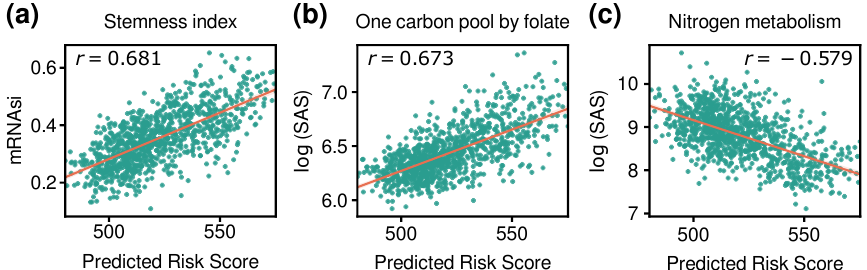
Figure 7. Scatter plots represent the relationship between the risk score and other indices. ( a ) The stemness index is a value to measure oncogenic dedifferentiation. The risk score showed a strong positive correlation with the mRNA stemness index ( p = 9.62 × 10 − 140 ). ( b ) SAS is a score to measure the degree of activity of a subsystem (e.g., pathway). The risk score showed a strong positive correlation with one carbon pool by folate pathway (hsa00670) ( p = 1.56 × 10 − 135 ). ( c ) The risk score showed a strong negative correlation with nitrogen metabolism (hsa00910) ( p = 2.69 × 10 − 92 ). r indicates Pearson’s correlation coefficient, and p -values are the results of two-tailed correlation